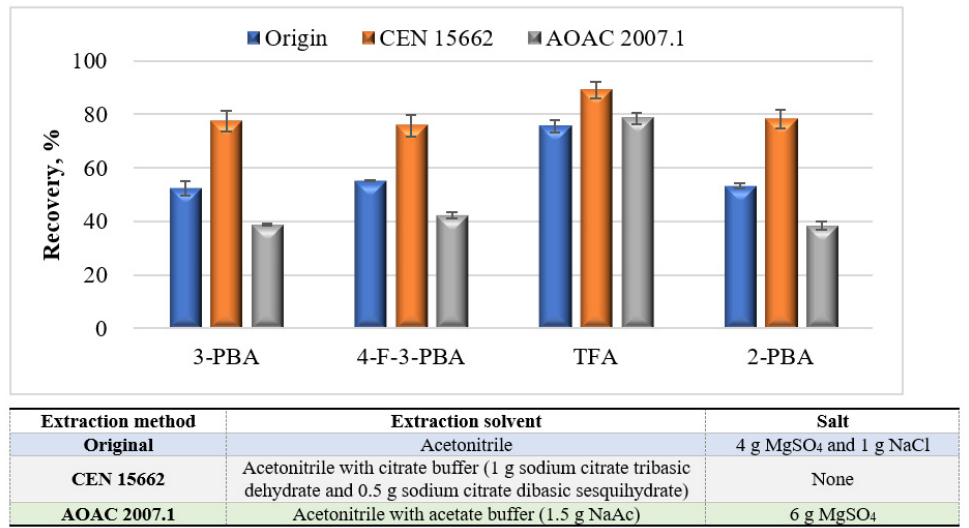
Figure 3. Recoveries of three analytes and internal substances with the extraction methods of original “quick, easy, cheap, effective, rugged and safe” (QuEChERS), CEN 15662, and AOAC 2007.1. Table 2. Recoveries of target compounds after clean-up by amino carbon nanotubes (NH 3 -NTs), multi-walled carbon nanotubes (MWCNTS), graphite carbon black (GCB), octadecylsilane (C18), primary secondary (PSA), polyvinylpyrrolidone (PVPP), florisil, and zirconia (ZrO). Adsorbents